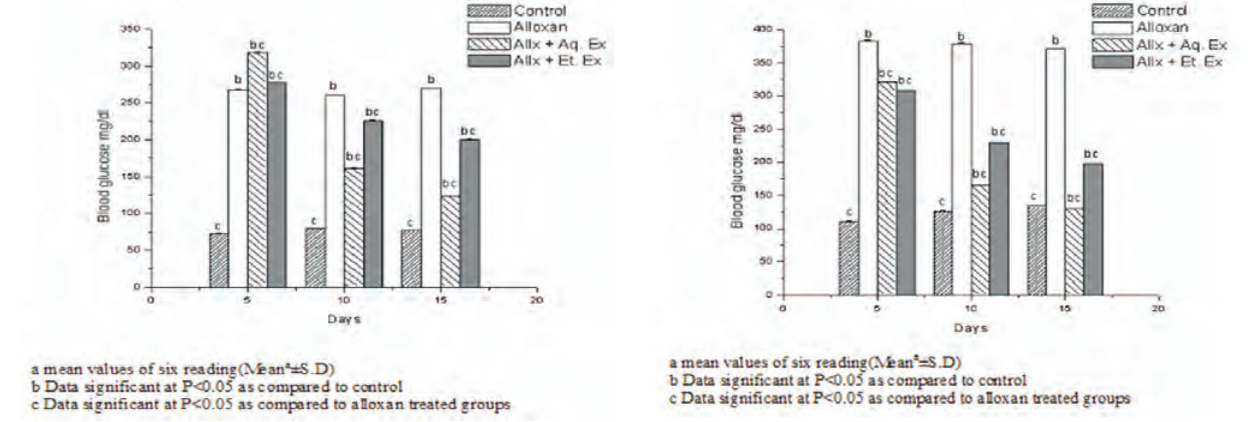
Figure-3. Effect of Aq.Ex and Et.Ex of A graveolens L. on blood Figure-4. Effect of Aq.Ex and Et.Ex of A graveolens L. on Blood glucose level (fasting) expressed as mean ±SD. glucose level (PP) expressed as mean ±SD. Table-1. Effect of Aq.Ex and Et.Ex of Anethum graveolens L. on hematological parameter expressed as mean ±SD. Hematological Parameters Control Allx +